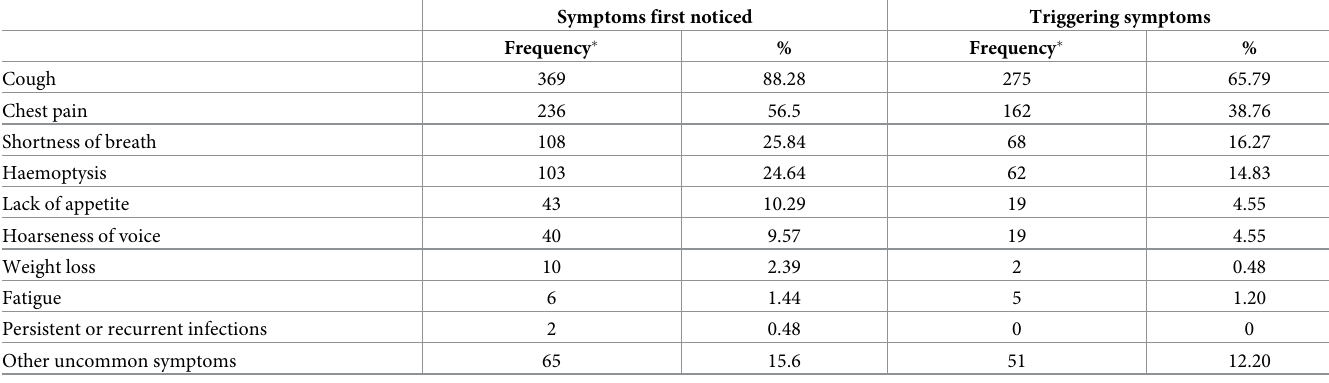
Table 2. First symptoms and triggering symptoms to seek healthcare provider (n = 418).